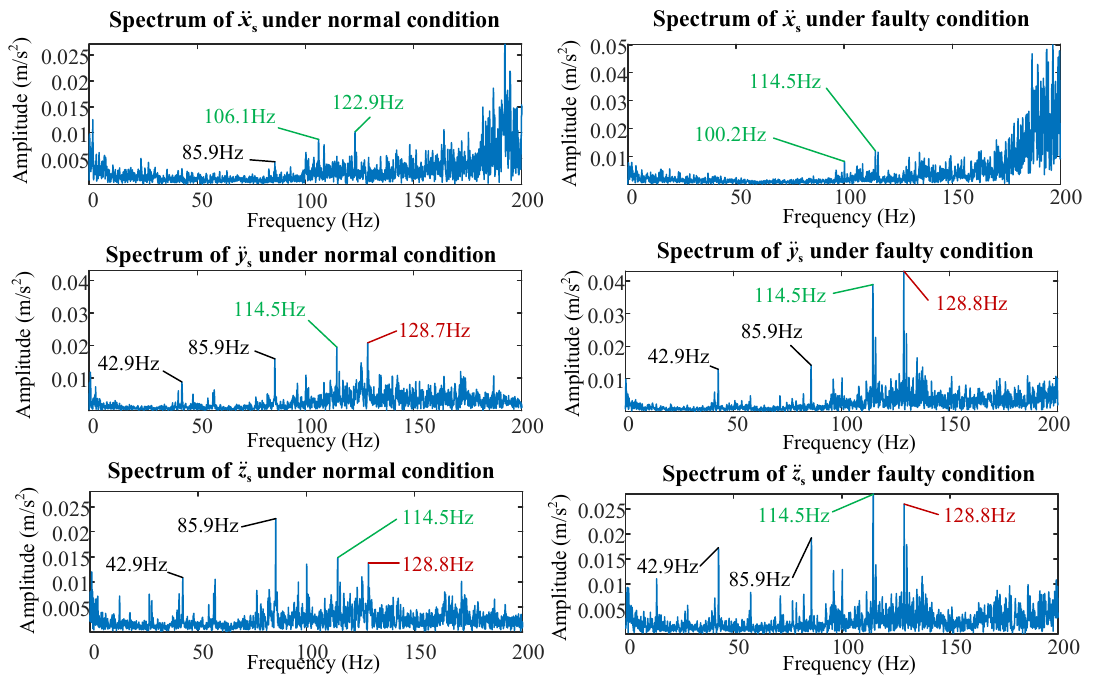
Figure 17. Experimental acceleration spectra of the screw-shaft-related parameters under normal and faulty conditions (the acceleration values are calculated from the voltage values, which are directly measured by the accelerometers).